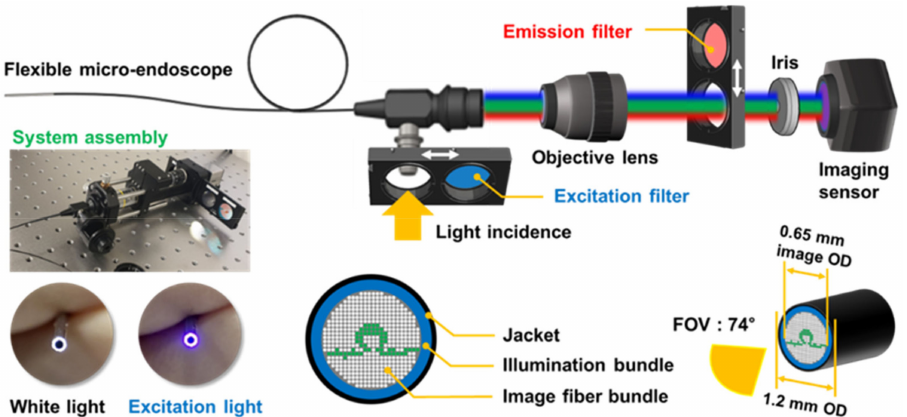
Figure 2. Optical structure and dimensions of the microendoscopy-based fluorescence sensing